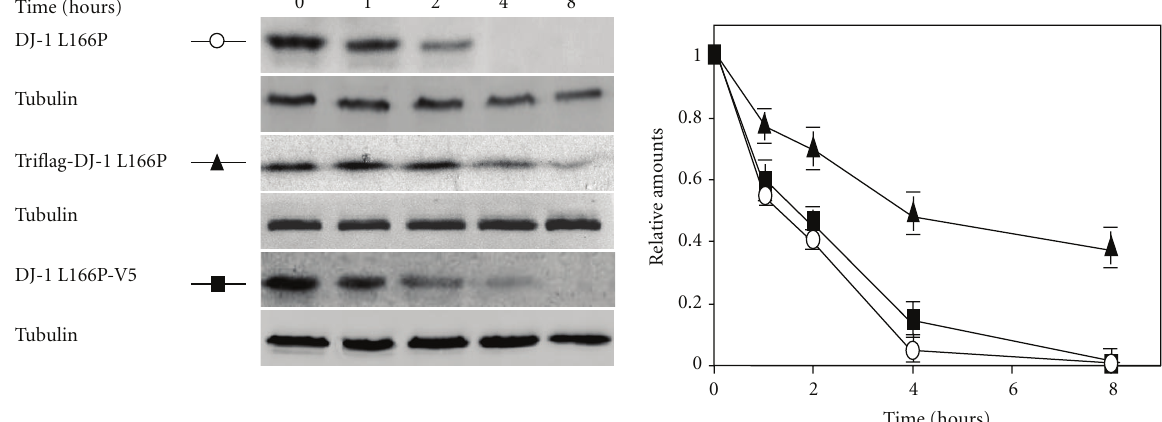
Figure 2: Degradation of untagged and N-terminus and C-terminus tagged versions of human DJ-1 L166P. The untagged human DJ-1 L166P (hDJ-1 L166P) construct has been described previously [49]. The C-terminal His-V5 tagged hDJ-1 L166P was obtained by PCR amplification with the following oligonucleotides (forward BamH1-DJ-1; 5 (cid:3) GGAAGGATCCATGGCTTCCAAAAGAGCTCTGG 3 (cid:3) and reverse Nonstop- hDJ-1; 5 (cid:3) GTCTTTAAGAACAAGTGGCGCCTTCACTTGAGC 3 (cid:3) ) and cloned into pcDNA 3.1/V5-His Topo vector from Invitrogen The N-terminal 3xFlag- tagged hDJ-1 L166P was obtained by PCR amplification with the following oligonucleotides (forward BamH1-hDJ-1 and reverse XhoI-hDJ-1 5 (cid:3) GCGCCTCGAGCTAGTCTTTAAGAACAAGTGGAGCC 3 (cid:3) ) and cloned into the pCMV-3Tag 1-A vector. N2a cells were cultured in DMEM medium with 10%FBS and transiently transfected with the di ff erent hDJ-1 L166P constructs. Transfected cells were treated with cycloheximide (20 μ g/mL) for the times indicated and analyzed by Western immunoblotting with anti-hDJ-1specific antibodies, as described in [49]. Results presented are expressed as mean ± s.e.m for at least three independent experiments.